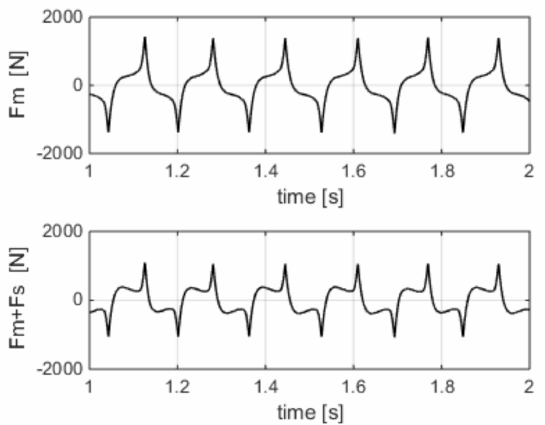
Figure 14. The waveforms of the resultant magnetic force ( F m ) and the resultant force (mag- netic + spring force ( F m + F s )) acting on the upper piston.